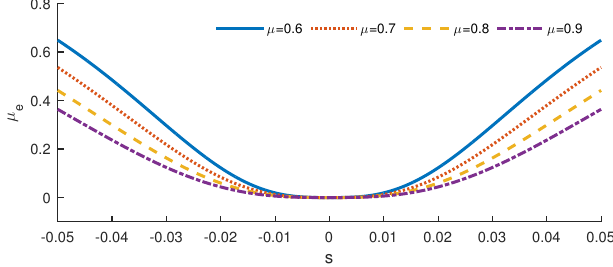
Figure 11. Effectiveness factor as a function of the tire slip ratio for different friction coefficients.